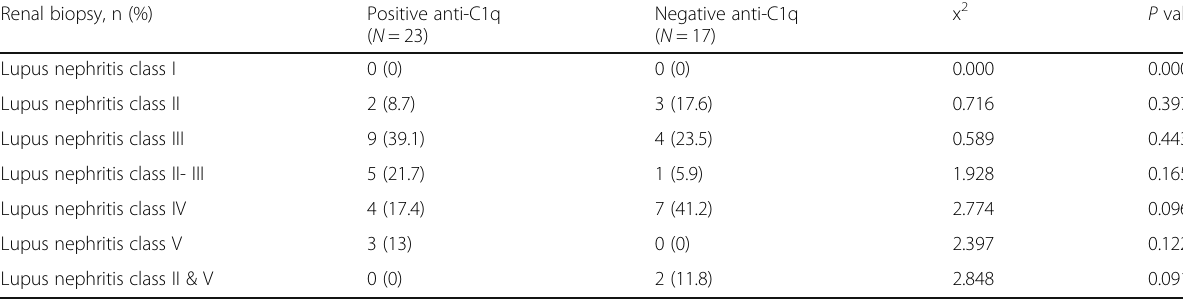
Table 5 Relationship between anti-C1q antibody and renal histopathology in patients with LN Renal biopsy, n